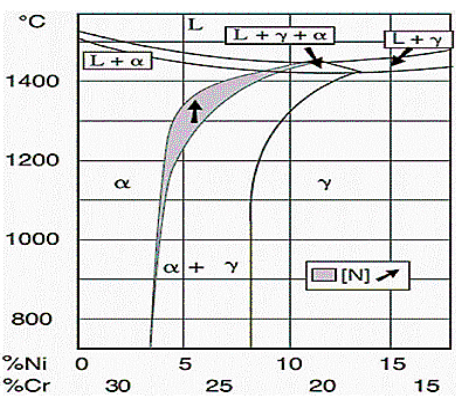
Figure 2. Pseudo-binary Fe-Cr-Ni phase at 70% Fe section illustrating areas of detrimental phase formation [34].